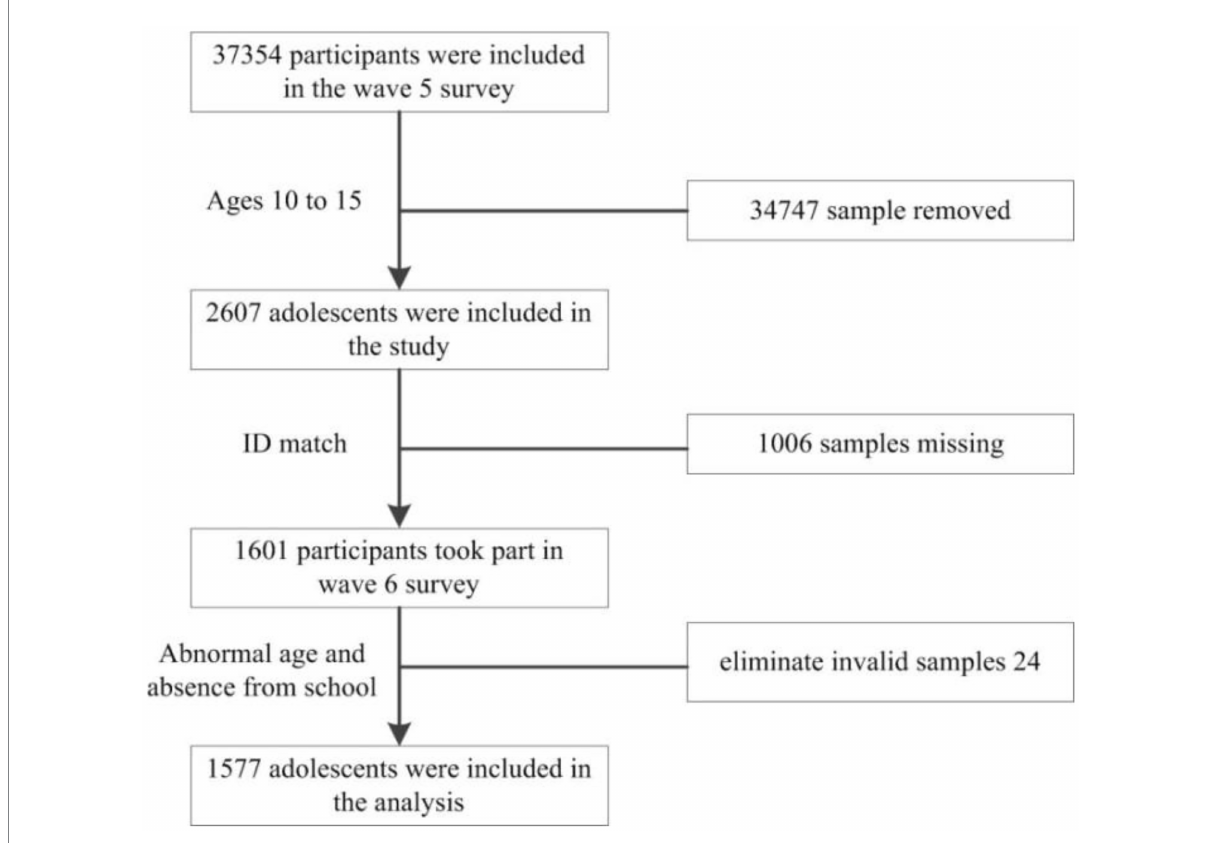
FIGURE 2 Flowchart of the inclusion and exclusion of